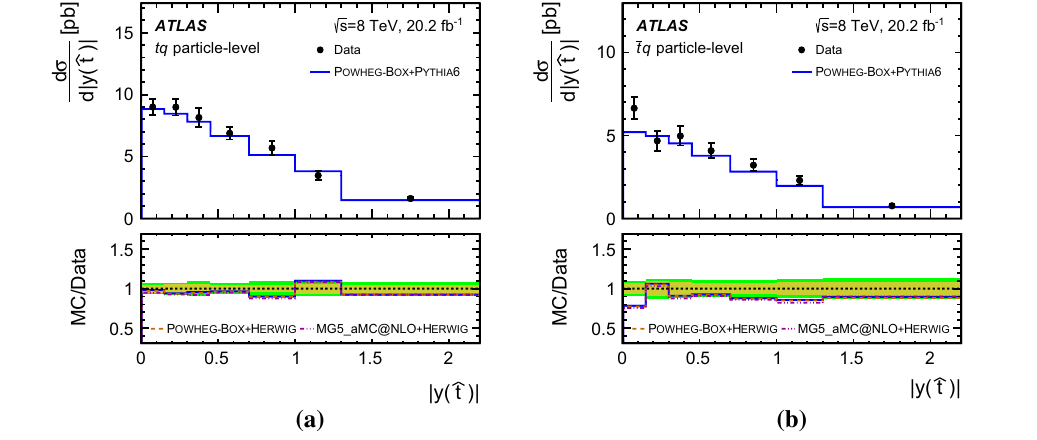
Fig. 18 Absolute unfolded differential cross-sections as a function of | y ( ˆ t ) | for a top quarks and b top antiquarks. The unfolded distributions are compared to various MC predictions. The vertical error bars on the